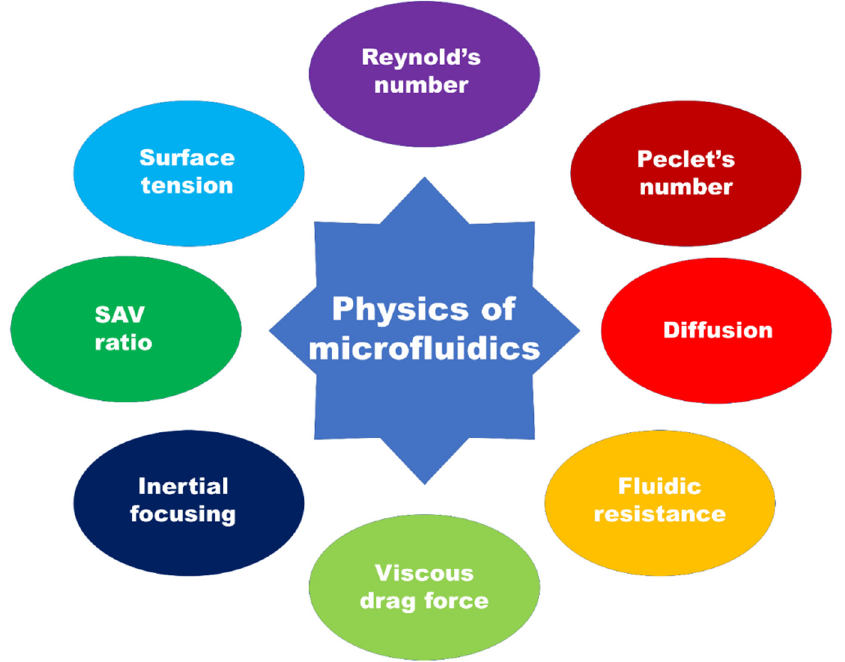
Figure 4. Illustration showing the basic principle of microfluidics in relation to various physical phenomena.